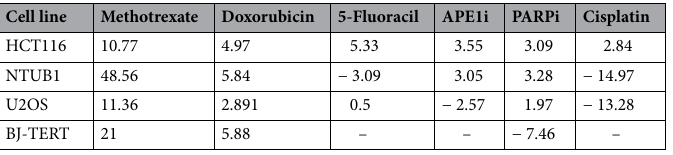
Table 1. ZIP synergy scores for conventional chemotherapeutic drugs or BER inhibitors in combination with TH5487.